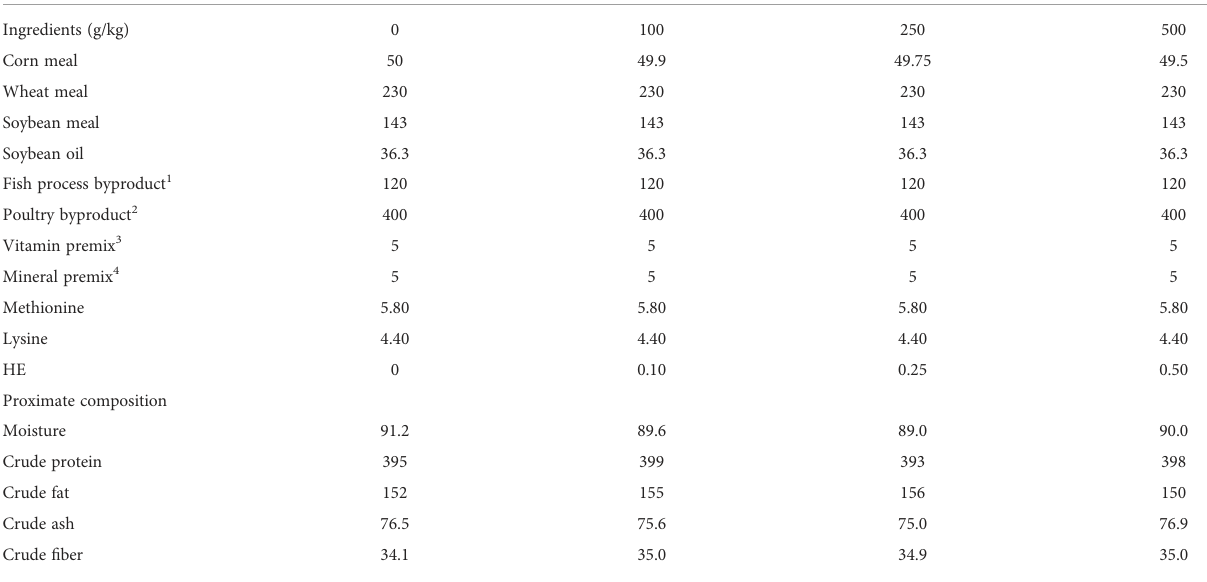
TABLE 1 Feedstuffs ’ proportion and chemical composition of the experimental